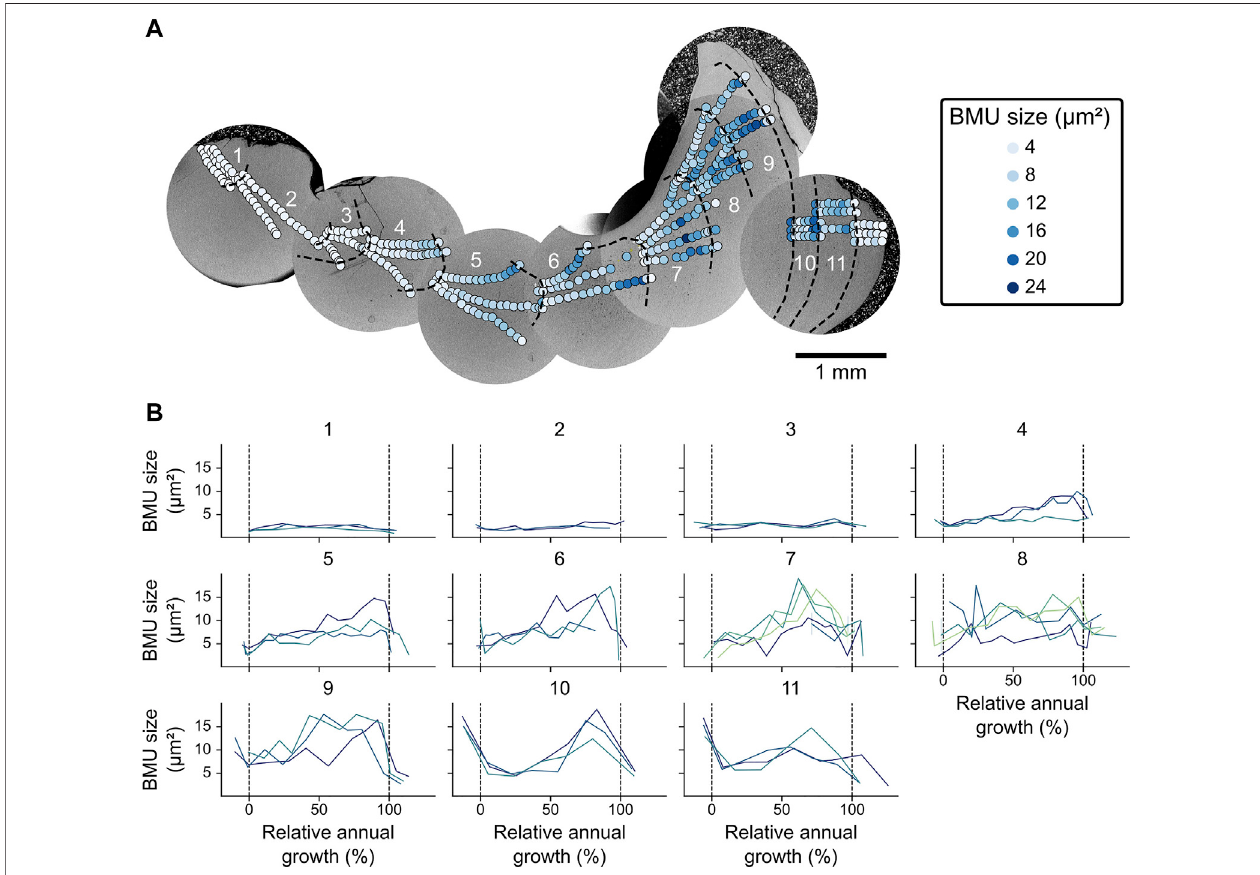
FIGURE 6 | Spatial BMU size variability in the hinge plate of Arctica islandica specimen ICE06-6.2-A6R. (A) The BMU size varies strongly across and within the annual growth increments (labeled 1 through 11), but is largely similar in contemporaneously formed portions of the same annual increment. (B) Within each annual increment, the BMU sizes of different transects agree well with each other and show a sinusoidal pattern from age four onward. Merely increment seven and eight exhibited weaker correlation and less prominent seasonal patterns.